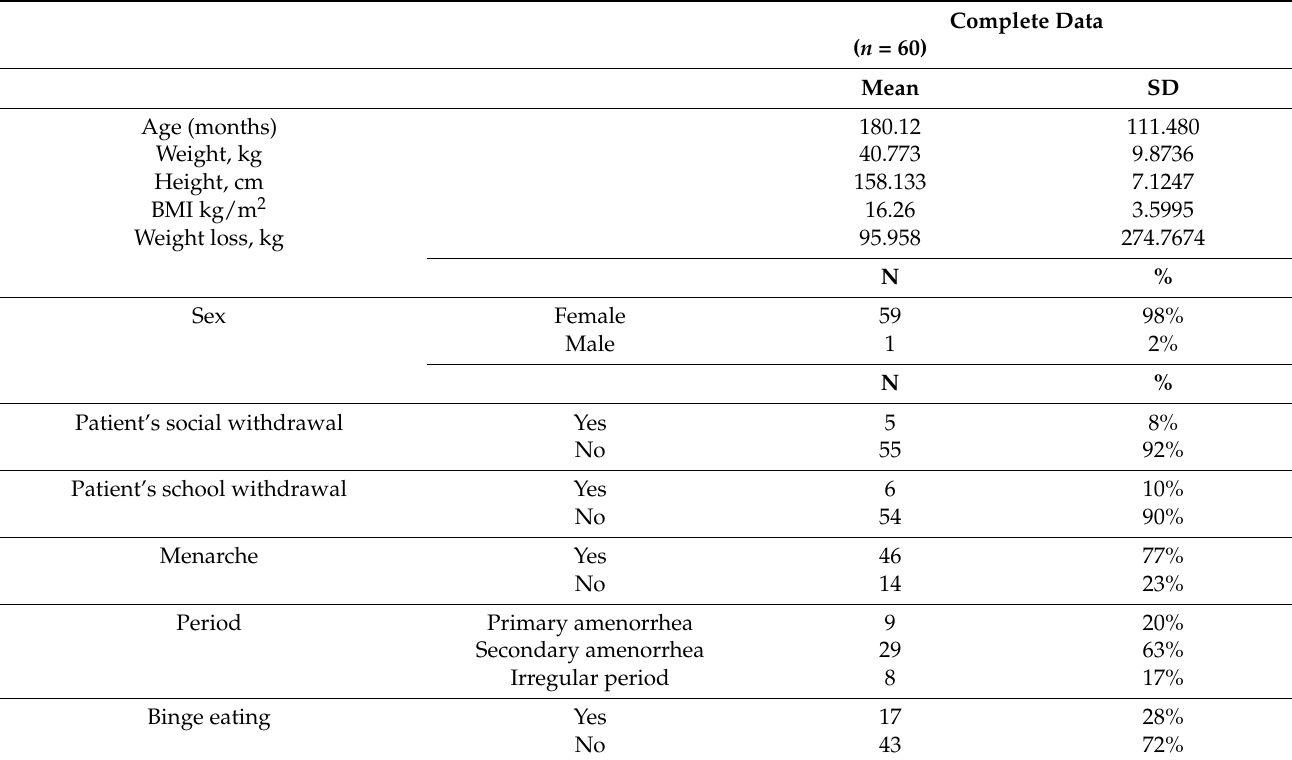
Table 3. Descriptive statistics of the